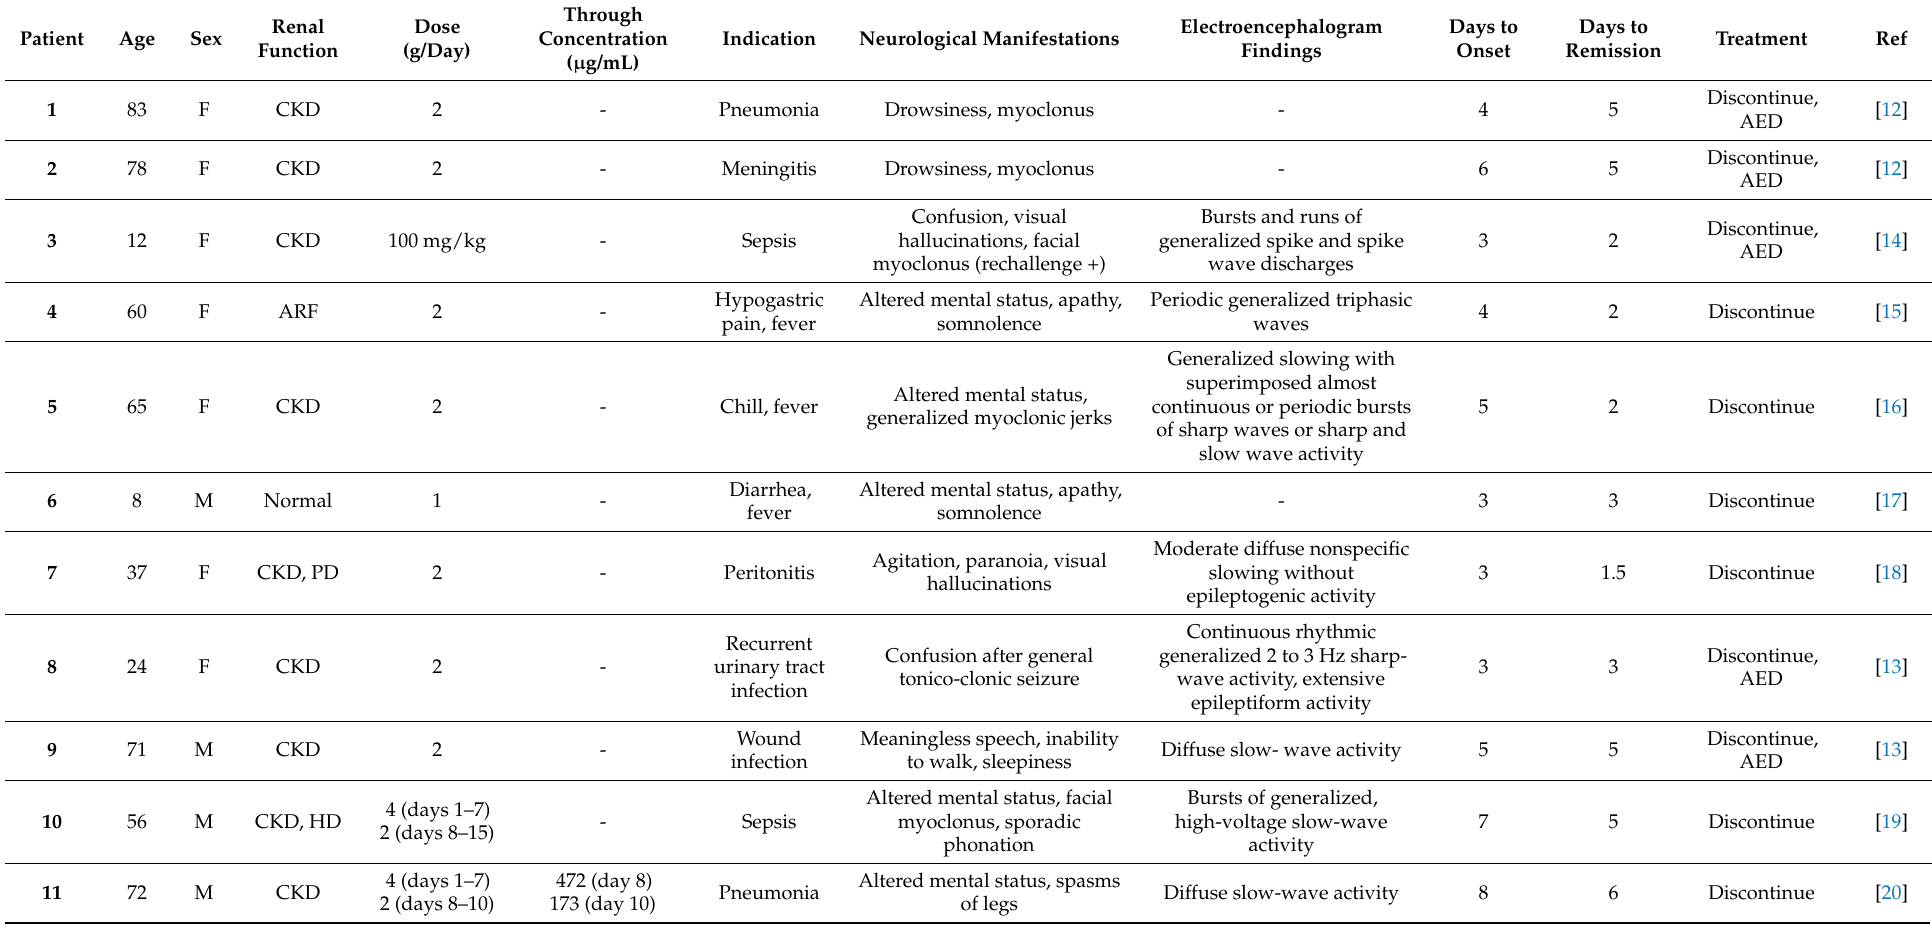
Table 2. Systematic literature review of neurotoxicity attributable to